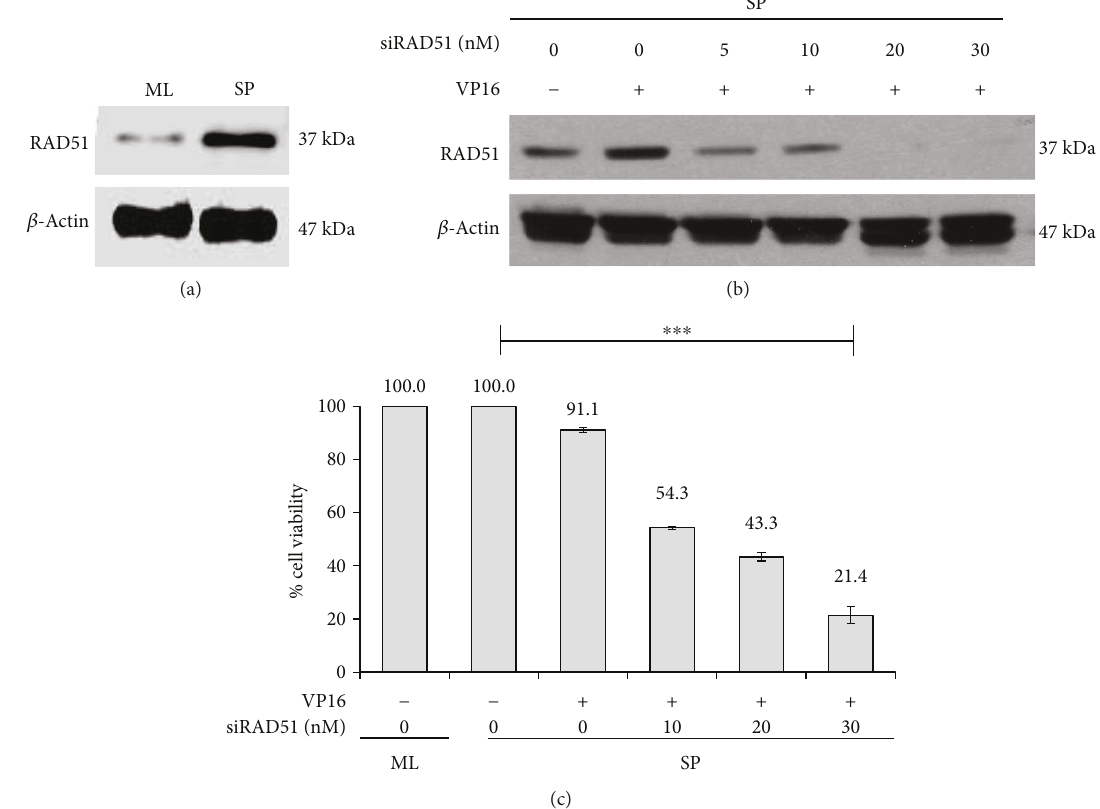
Figure 3: Inhibition of RAD51 decreases cell viability. (a) Western blot analysis showing RAD51 is overexpressed in HeLa SP cultures compared to the monolayer ones. (b) RAD51 expression is induced by Etoposide and e ffi ciently inhibited by siRNA targeted to RAD51 (siRAD51). Western blot analysis shows that RAD51 expression is inhibited by increased amounts of siRAD51 (5, 10, 20, and 30nM) in the presence of 5.8 μ g/mL of VP16 for 48h. (c) Inhibition of RAD51 expression in sphere culture sensitizes to VP16. Cell viability of spheres measured by MTT decreases with increasing concentrations of siRAD51 in the presence of VP16. ∗∗∗ p < 0 001